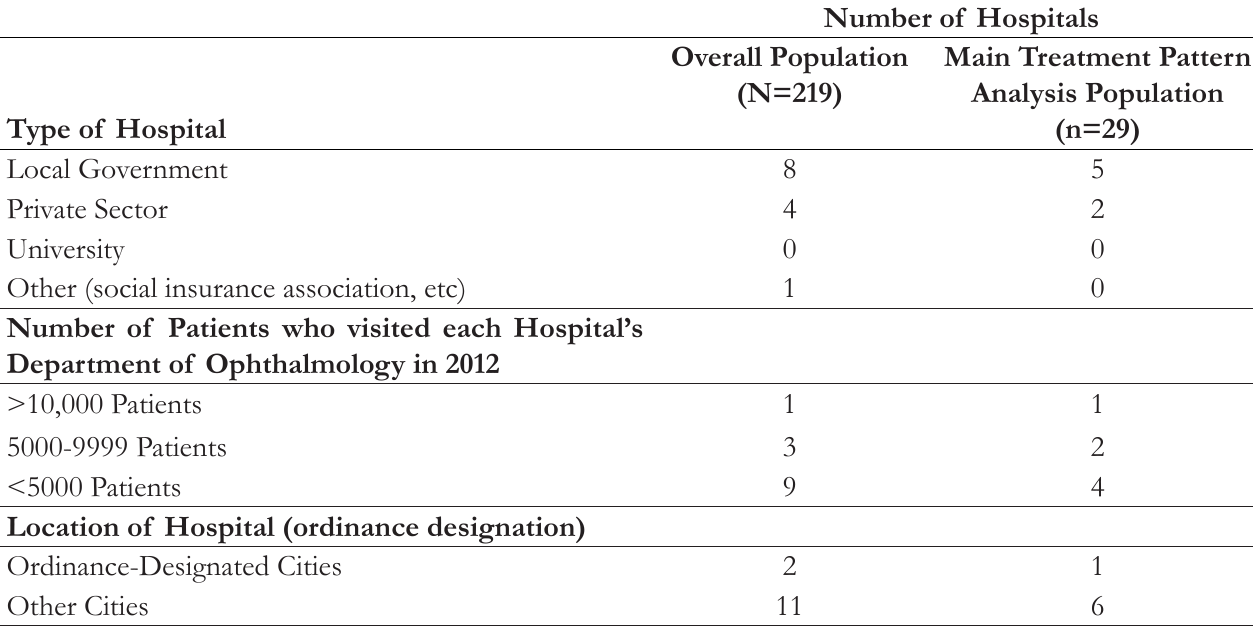
Table 1. Description of 13 Hospitals visited by Study